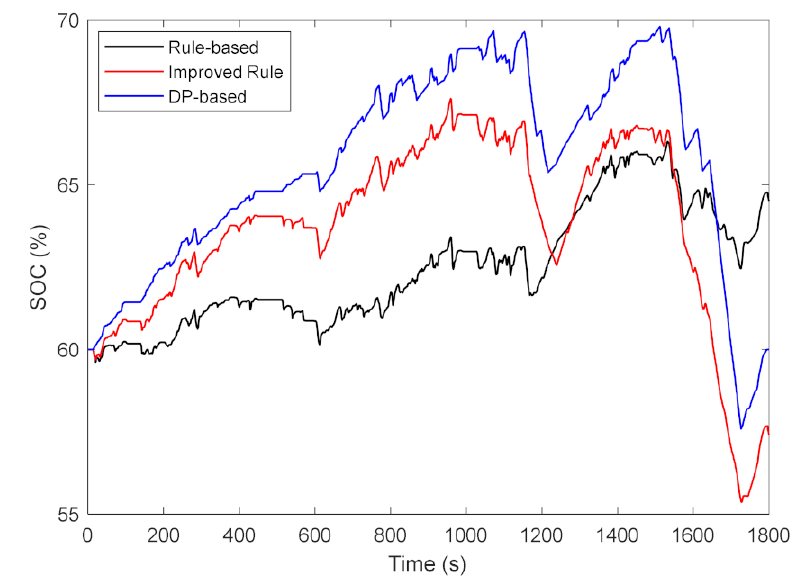
Figure 18. Change trend of SOC before and after improvement. During the actual operation of the vehicle, the SOC may also deviate from the target range. At this time, the EMS should enable the vehicle to maintain the SOC within the target range after running for a period of time. In order to verify this situation, under the WLTC driving cycle, the SOC is set to different initial values for simulation and the results are shown in Figure 19. The improved rule-based strategy is able to maintain the SOC within the target range of 0.5 to 0.7 under different initial SOC values.